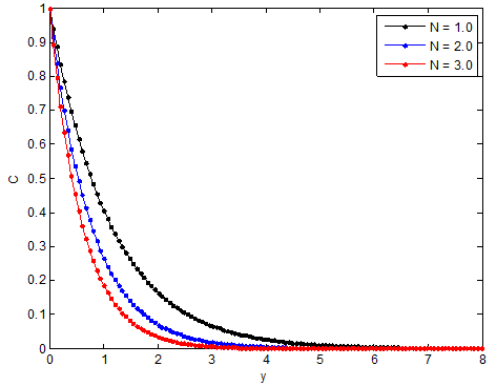
Figure 21. Effects of buoyancy ratio on the concentration distribution